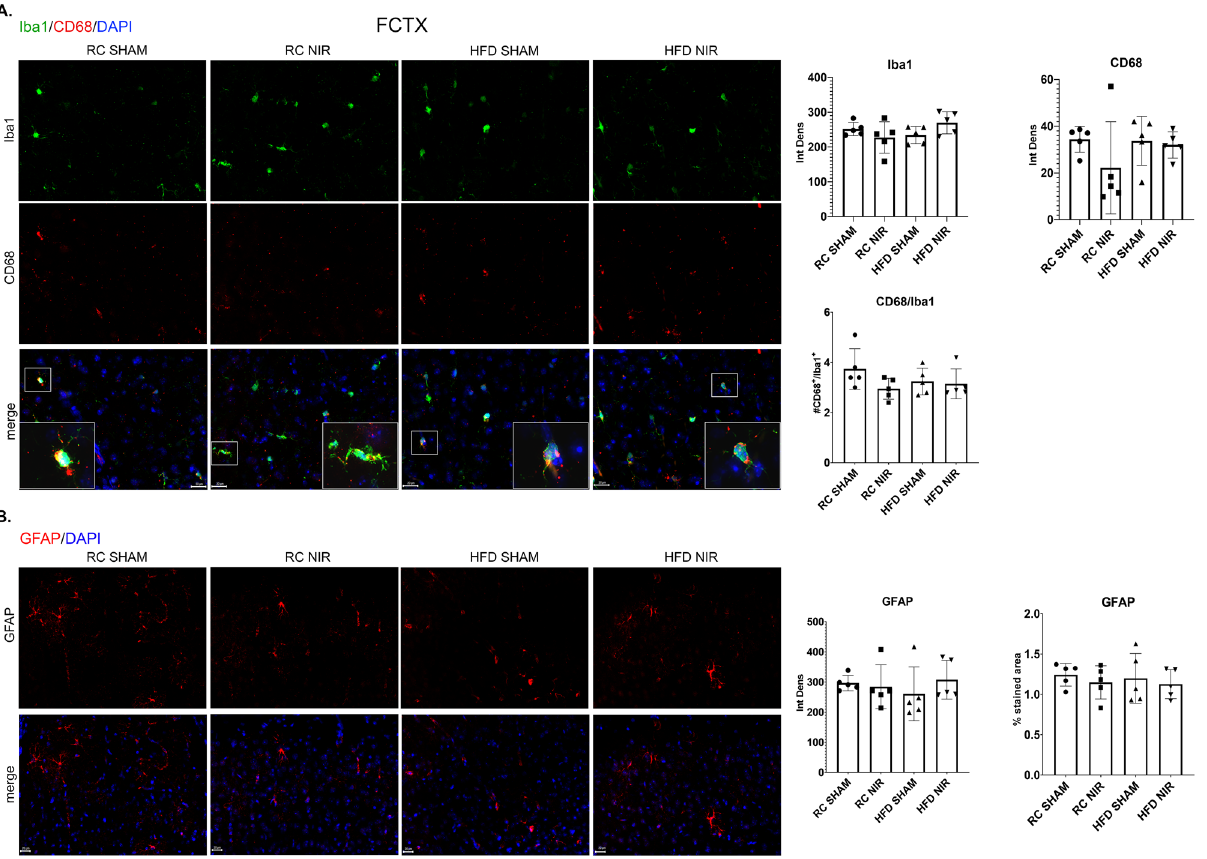
Figure 6. Glia marker expression in the FCTX of RC- and HFD-fed mice with or without NIR. ( A ) Quantitative analyses of microglia markers in the FCTX did not show any significant differences in Iba1 or CD68 among groups. Magnification: 60X. ( B ) GFAP immunoreactivity was similar in all groups. Magnification: 40X. Image results of Z-stacks with pitch of 2.0 of μm. n = 5 animals/group. Data are presented as mean ± SD. Each point is the average of 6 images/animal from 2 technical replicates. Statistical analyses: one-way ANOVA with Tukey’s post-hoc test. Single images were generated with Keyence BZ-X800 Analyzer (www. keyen ce. com). Graphs were created with GraphPad Prism 8.4.3 and 9.3.1 software (https:// www. graph pad. com/). Images and graphs were composed in Adobe Photoshop 22.2.0 (https:// www. adobe. com/ produ cts/ photo shopf amily. html).